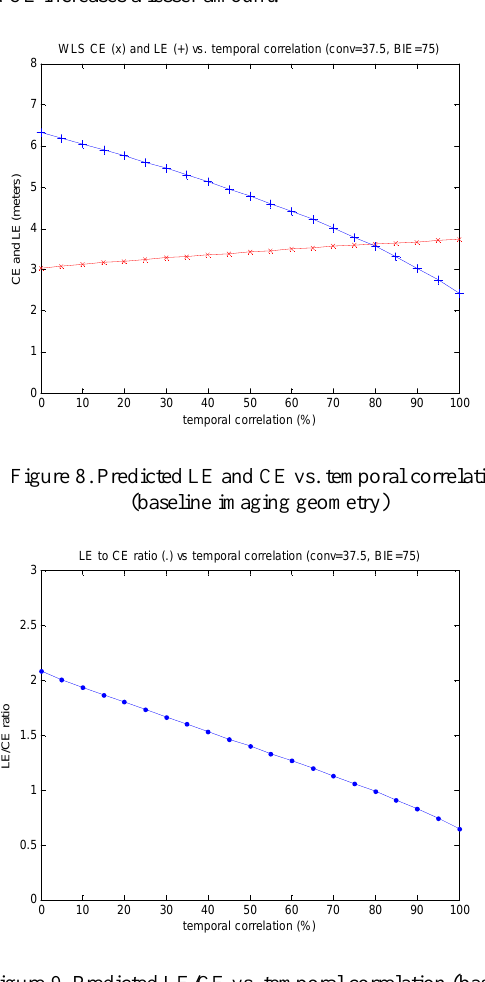
Figure 9. Predicted LE/CE vs. temporal correlation (baseline imaging